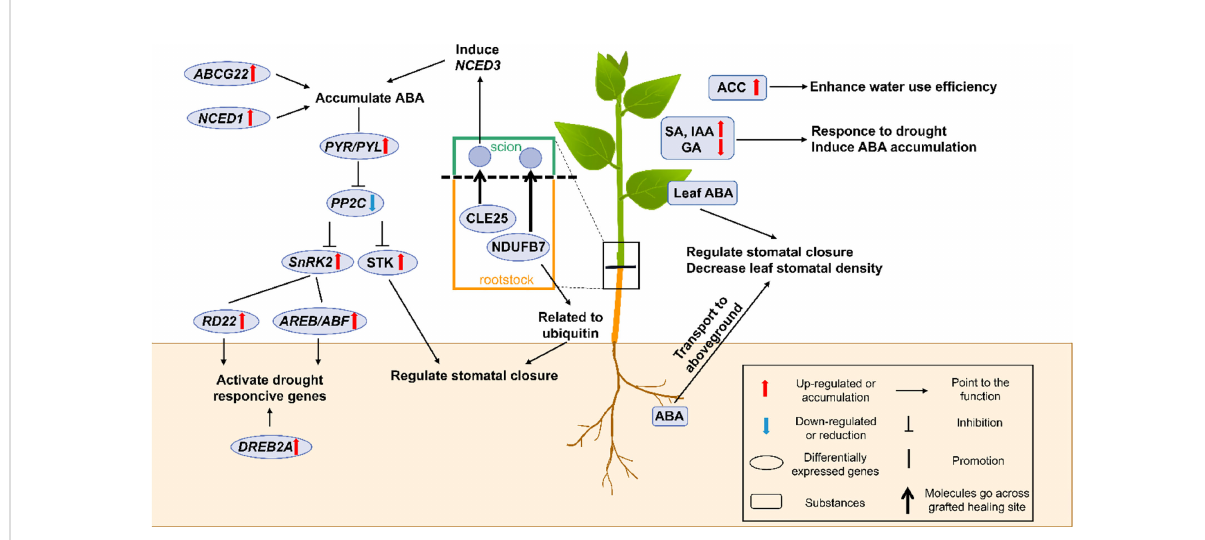
FIGURE 2 A schematic model shows the physiological and molecular mechanisms that enhancing drought resistance by the accumulation of phytohormones (especially ABA) in grafted plants. In grafted plants, the green part represents for the scion, and the brown part represents for the rootstock. The box shows the fi gure notes. ABA, abscisic acid; ABCG22 , ATP-binding cassette subfamily G transporter 22 ; ACC, ethylene 1- amynocyclopropane-1-carboxylic; AREB/ABF , ABA-responsive element binding protein / ABA-responsive element binding factor ; CLE25, clavata3/embryo-surrounding region-related 25; DREB2A , dehydration-responsive element-binding protein 2 A ; GA, gibberellin; IAA, Indole-3- acetic acid; NCED1 and 3 , 9-cis-epoxycarotenoid dioxygenase 1 and 3 ; NDUFB7, NADH-ubiquinone oxidoreductase B18 subunit; PP2C, protein phosphatase 2C; PYR/PYL , pyrabactin resistance1/pyr1-like ; RD22 , responsive to dehydration 22 ; SA, salicylic acid; SnRK2 , sucrose non- fermenting-1-related protein kinase 2; STK , serine/threonine-protein kinase-transforming protein